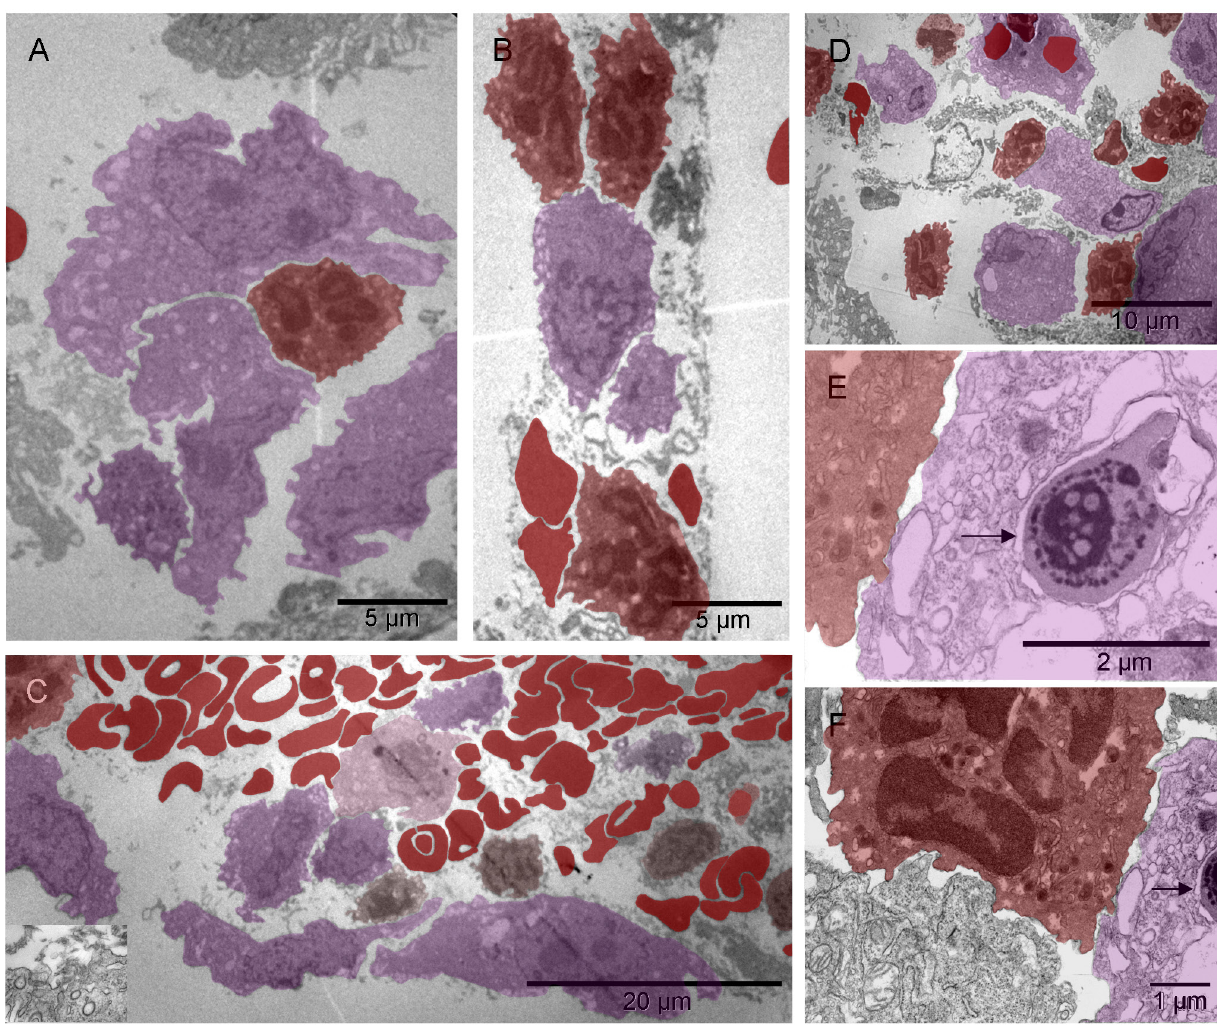
Figure S1. A blueprint for vascular pattern created by migrating erythroblasts and megakaryocytes. The pattern-forming heterogeneous population of the cells migrating in the hyaline membrane consisted of (a) those with large nuclei occasionally containing double nucleoli and with asymmetrically distributed, irregularly shaped, large cytoplasm and satellite platelets i.e., megakaryocytes (purple), and (b) those with atypical, lobular, heterogeneously dark nuclei and dark cytoplasmic granules in the absence of mitochondria, usually accompanied by erythrosomes (red), i.e. most likely erythroblasts (light red) [ A ]. The four elements, cellular and sub-cellular (erythrosomes and platelets), appeared evenly dispersed among each other like in the narrow (about capillary short dimension) column in [ B ] or the megakaryocytes that displayed a tendency to migrate to the periphery of the larger cluster and surround the other elements [ C ]. Those poorly differentiated cells were probably bipotent, megakaryocyte and erythroid, progenitors (brown) [ C ]; compare with Figure 8 in 55 . The cellular and sub-cellular elements appeared to be held together with extracellular fibrous components, possibly proteoglycans and little collagen (the insert in [ C ]). The resulting red pattern appeared as a vascular network under low magnification of dissecting microscope. The parallel arrangement of extracellular, short, non-collagen fibers suggested mobility for the cells secreting them [ D ]. The extra-cellular matrix (ECM) producer [ E ] located to the right of the erythroblast [ F ] contained a composite dense body (arrows in [ E & F ]) characteristic of platelets (see Figure 111-1, E in 56 ).